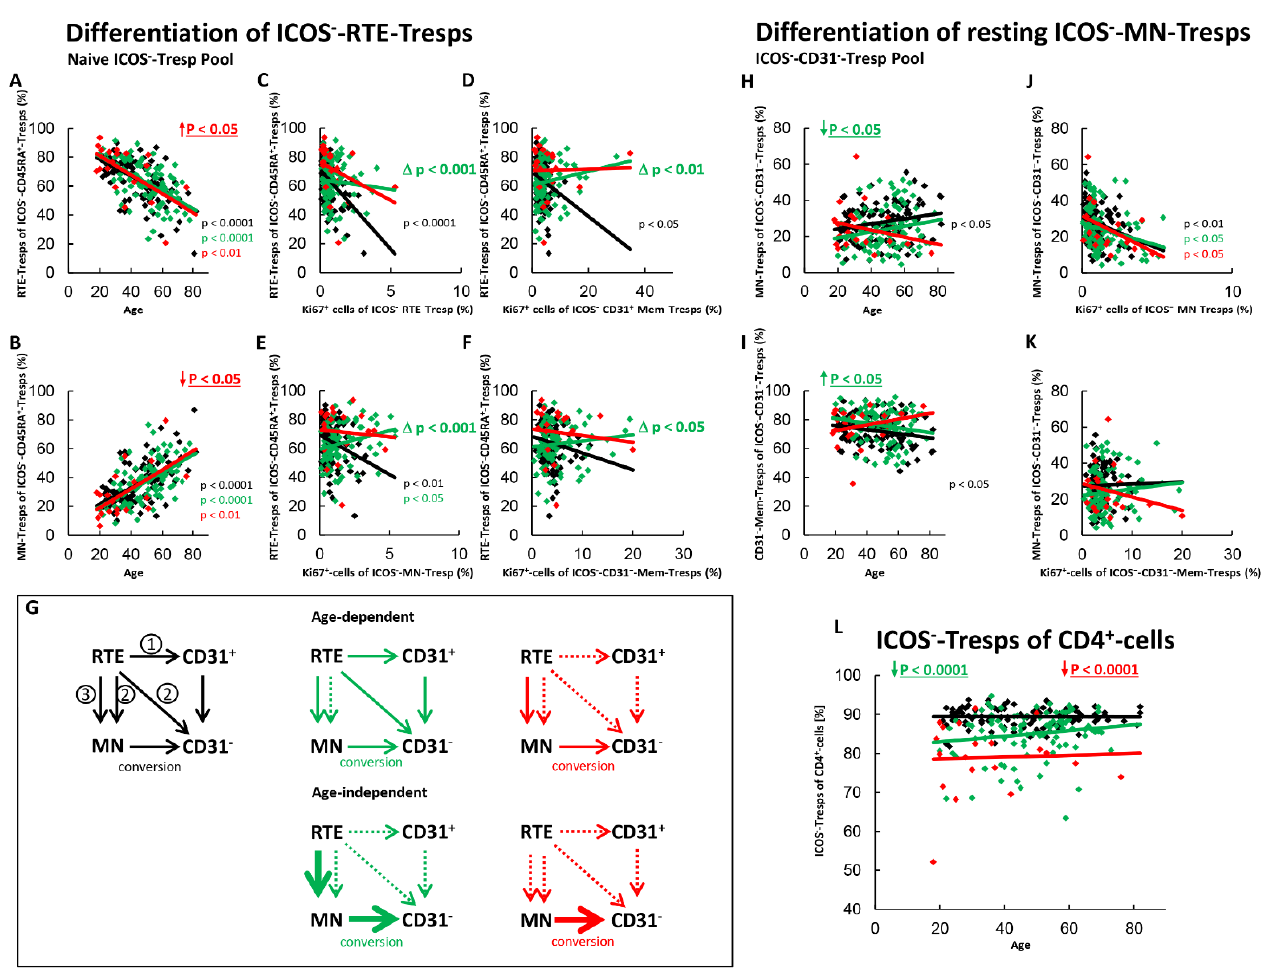
Figure 5. Differentiation of ICOS - -RTE-Tresps and resting ICOS - -MN-Tresps with age in healthy controls, SLE patients in remission and SLE patients with active disease. The percentages of RTE-Tresps and MN-Tresps within the naïve ICOS - - CD45RA + -Tresp pool ( A ) and ( B ) as well as the percentages of MN-Tresps and CD31 - -memory Tresps within the ICOS - - CD31 - - Tresp pool ( H ) and ( I ) were estimated depending on age, in healthy volunteers (Black coloured), SLE patients in remission (Green coloured) and SLE patients with active disease (Red coloured). In order to examine the differentiation of ICOS - -RTE-Tresps, the percentage of RTE-Tresps within total naïve CD45RA + -Tresps was correlated with the percentage of Ki67 + cells within total RTE-Tresps ( C ), CD31 + -memory-Tresps ( D ), MN-Tresps ( E ) and CD31 - -memory-Tresps ( F ). In order to examine the differentiation of resting MN-Tresp, the percentage of MN-Tresps within total CD31 - -Tresps was correlated with the percentage of Ki67 + cells within total MN-Tresps ( J ) and within total CD31 - -memory-Tresps ( K ). Significant linear regression analyses are marked by black, green, or red p-values. Significant differences in the regression lines between healthy controls and SLE patients in remission or active disease are marked by green or red ∆ p values. Age-independent significant differences between healthy volunteers and study groups are marked by an arrow ( ↑↓ ) and their color-matched P-values. The arrow diagrams ( G ) schematize an increased (thick arrow), consistent (thin arrow) or decreased (dashed arrow) differentiation, color matched for the different patient groups. The double arrow relates to the enrichment of resting MN-cells. The resulting age-dependent and age-independent changes in the percentage of ICOS - - Tresps within total CD4 + -T-helper cells are given in ( L ). Further information of the calculated p-values is illustrated in Table S1.